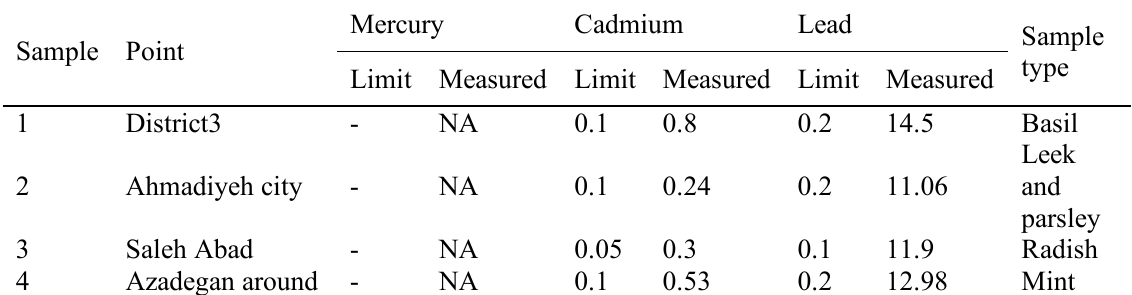
Table 12 . Plant sampling points